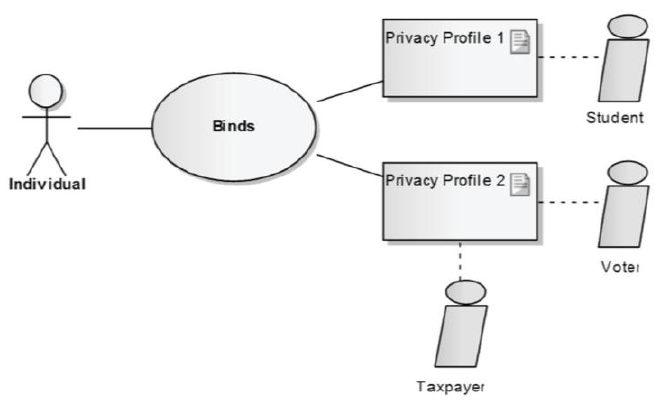
Figure 1. Identities and privacy profiles.